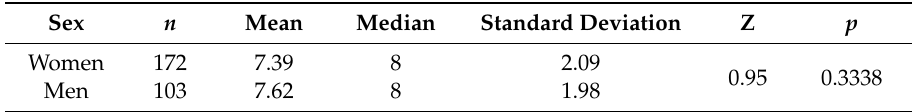
Table 7. The level of intensity of the motivation to participate in the Poznan Half Marathon in the future—depending on sex.